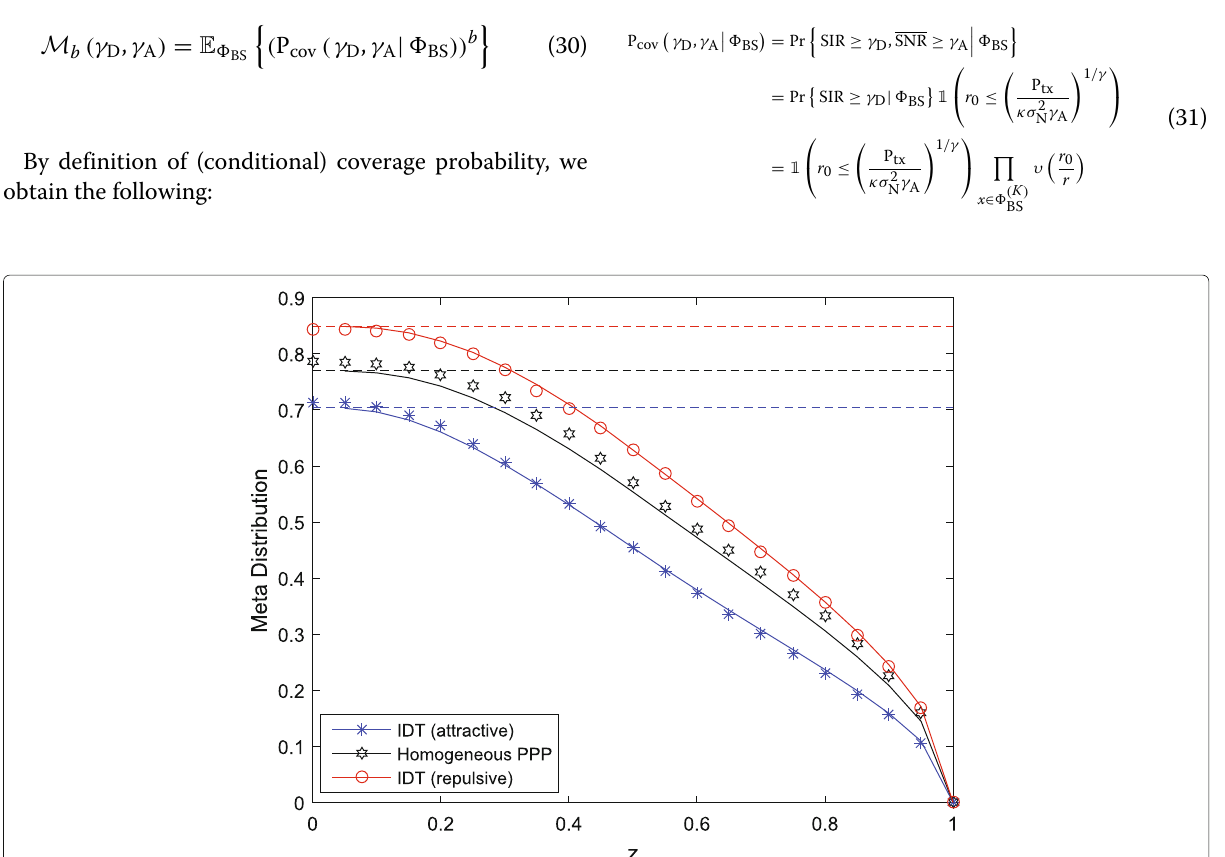
Fig. 4 Meta distribution. Setup: General case. Solid lines: IDT framework. Markers: Monte Carlo simulations. Dashed lines: asymptotic limit for z →